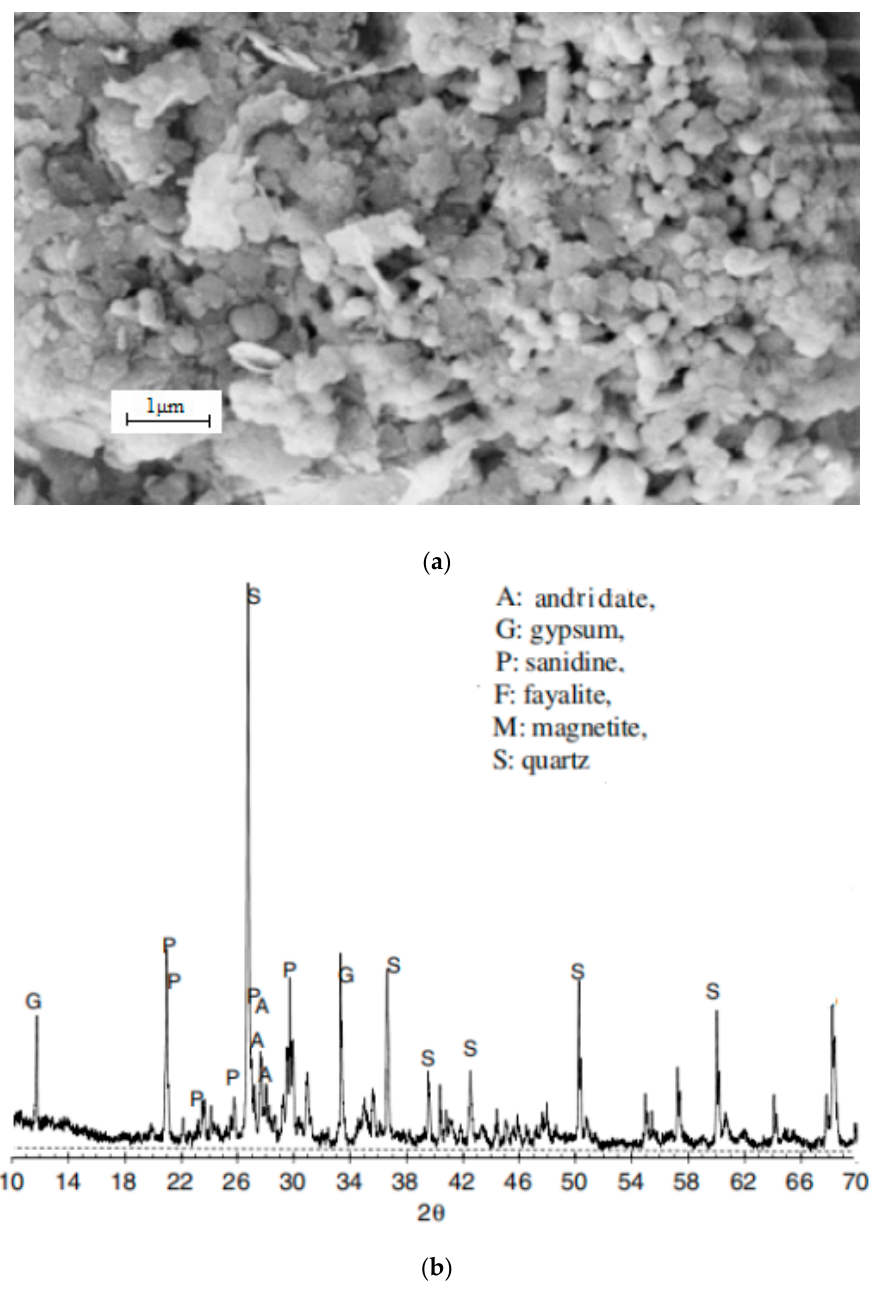
Figure 2. SEM (scanning electron microscope) and the XRD (X-ray di ff raction) of copper tailings: ( a ) SEM micro-graphs of copper tailings; ( b ) XRD pattern of copper